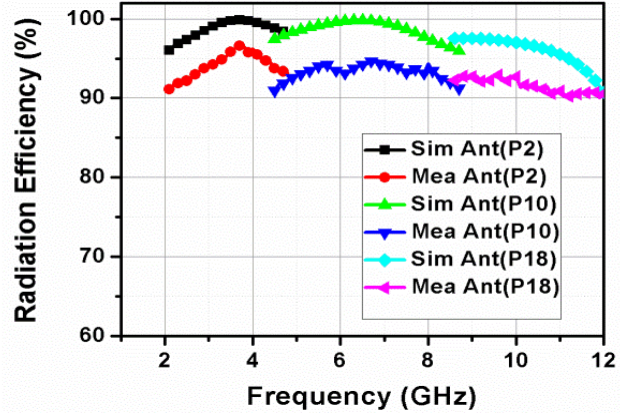
Figure 29. Peak gain of the sensing antenna.